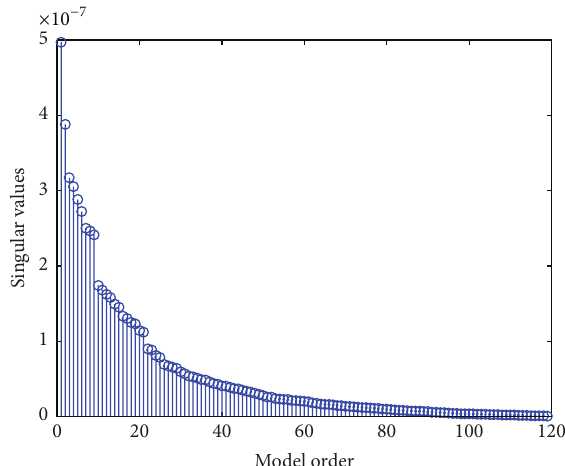
Figure 7: The footbridge: the singular values of output covariance matrix.